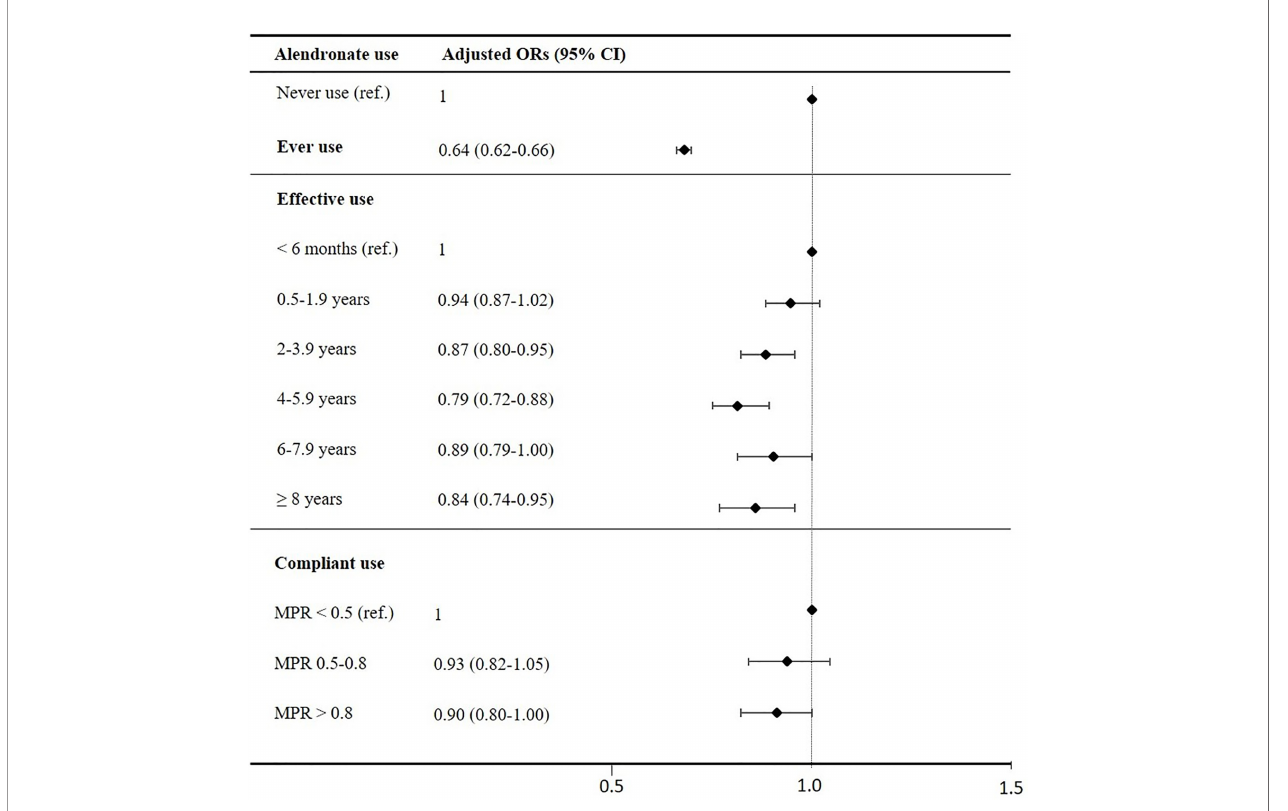
FIGURE 1 | Adjusted ORs for development of type 2 diabetes. ORs are adjusted for heavy smoking, alcohol abuse, obesity, pancreatitis, hyperthyroidism, hypothyroidism, steroid use, CCI, income, social status and presented with lower and upper CI 95% as error bars. The lowest categories (never users, effective users with use below 6months and compliant users with MPR below 0.5) as reference line